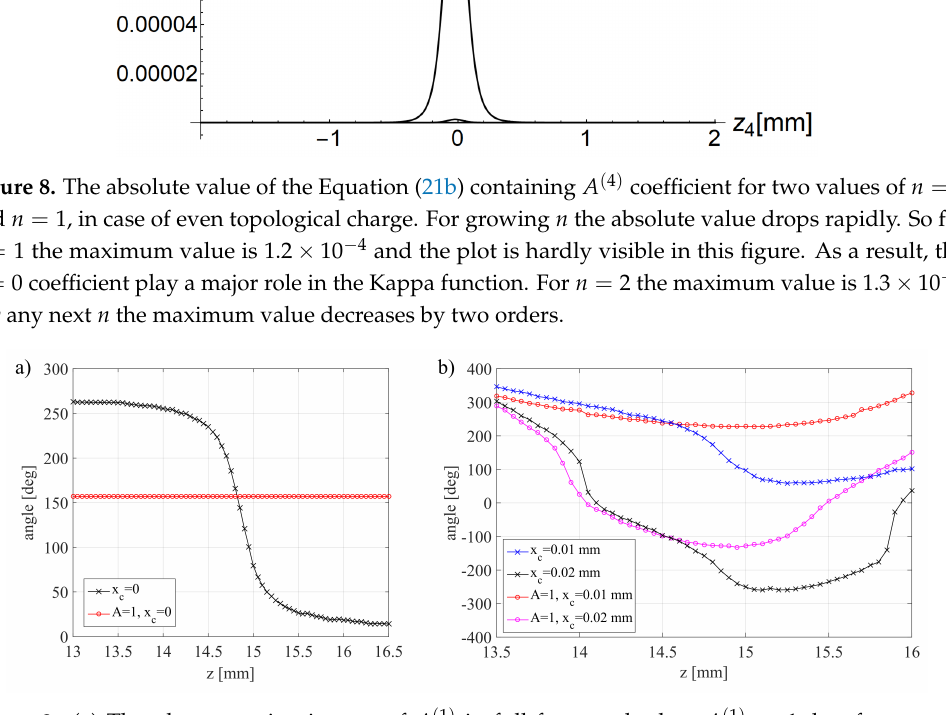
Figure 9. ( a ) The phase rotation in case of A ( 1 ) in full form and when A ( 1 ) = 1, but for x c = 0; ( b ) The same, but x c (cid:54) =